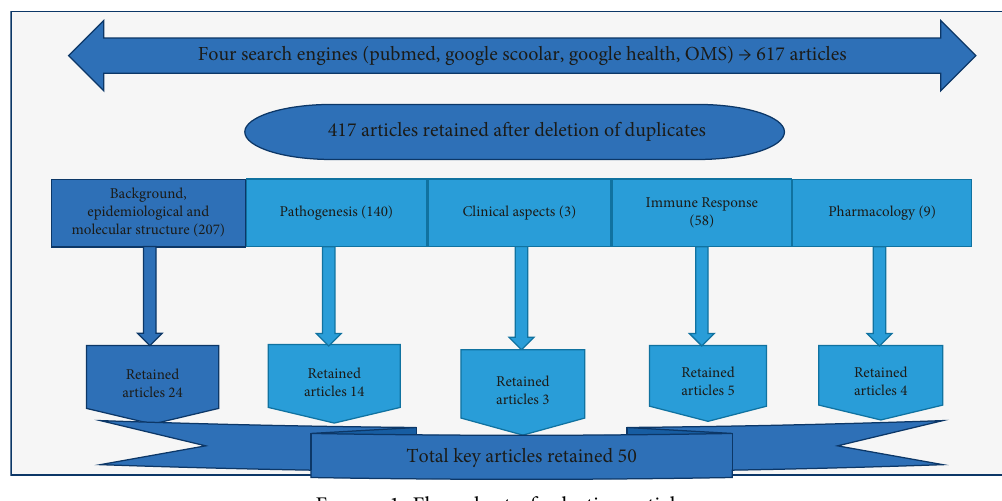
Figure 1: Flow chart of selecting